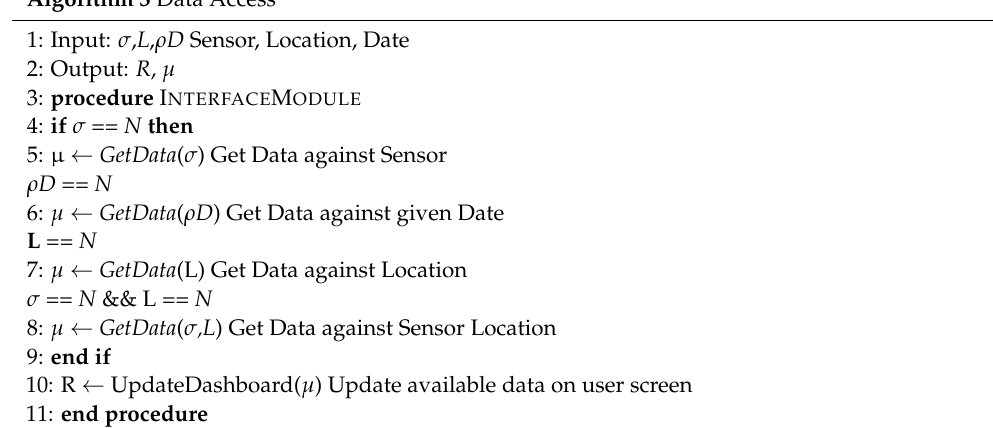
Algorithm 3 Data